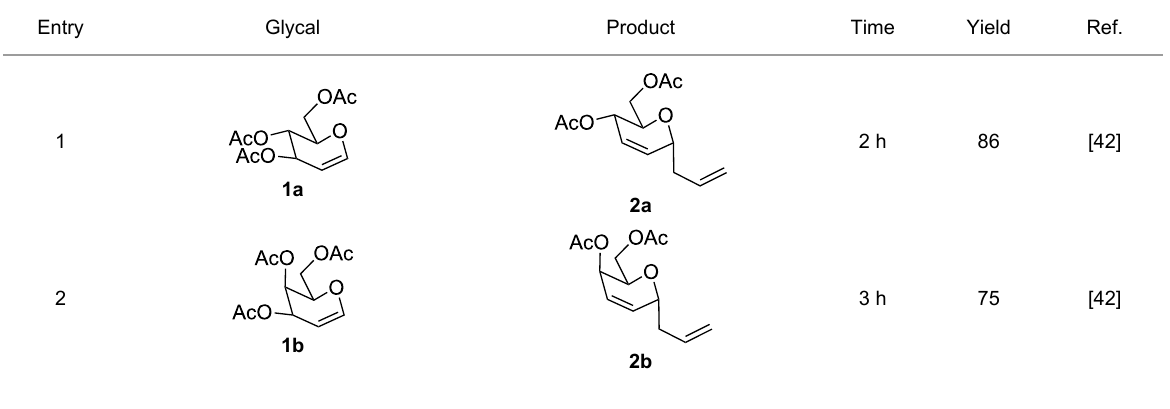
Table 2: Reaction of glycals with allyltrimethylsilane by using